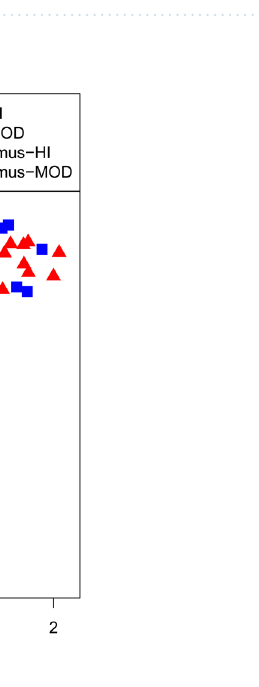
Figure 1. Venn diagram illustrating: ( a ) the variation in genes expressed across both the arcuate nucleus (ARC) and the remainder of the hypothalamus from all heifer calves, irrespective of their nutritional plane; ( b ) the number of differentially expressed genes (DEGs) in the ARC and the remainder of the hypothalamus of heifer calves on different nutritional planes. The solid lined box lists the transcripts common to both regions and their fold change (FC).